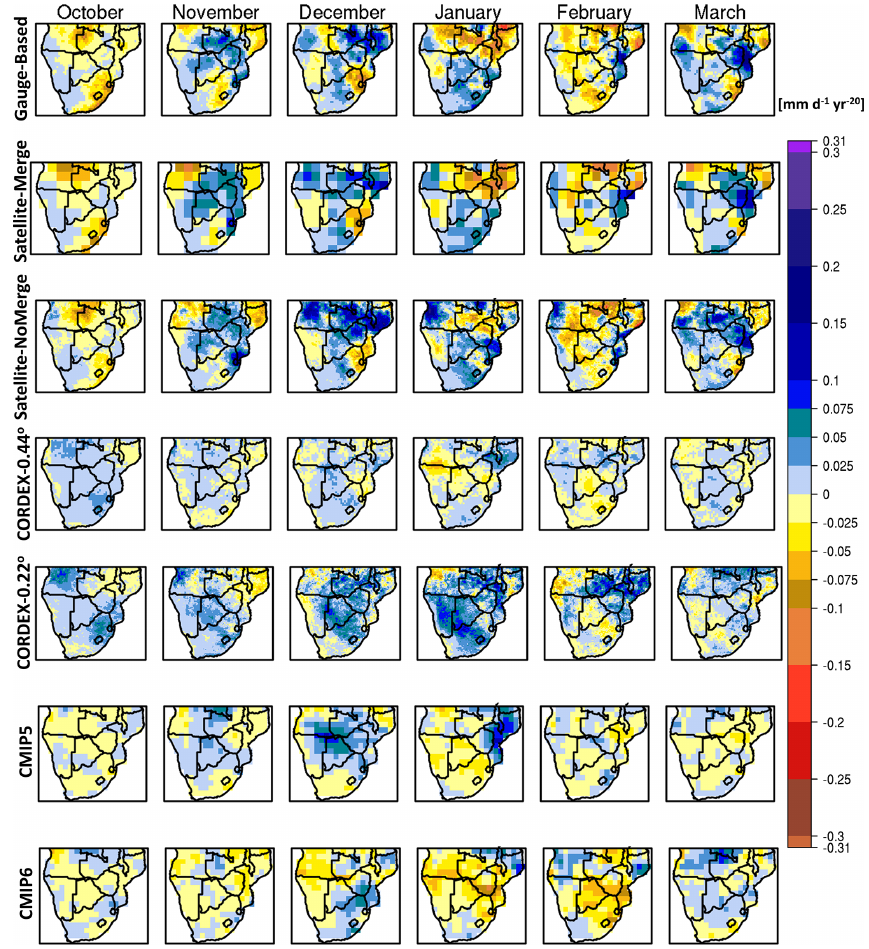
Figure 8. Trends for monthly precipitation for the period 1986–2005 [mmd − 1 per 20 years] calculated using Sen’s slope. Rows indicate the ensemble mean of trends produced by each ensemble member. From top to bottom – Gauge-Based: ensemble mean of datasets that were produced by employing spatial interpolation methods using rain gauges/station data. Satellite-Merge: ensemble mean of all satellite products that merge with rain gauges/station data. Satellite-NoMerge: ensemble mean of satellite products that do not merge with rain gauges/station data. CORDEX-0.44 ◦ : ensemble mean of regional climate model simulations performed in the context of the Coordinated Regional Climate Downscaling Experiment – Africa domain with a spatial resolution equal to 0.44 ◦ × 0.44 ◦ . CORDEX-0.22 ◦ : CORDEX-Africa simulations with a spatial resolution equal to 0.22 ◦ × 0.22 ◦ . CMIP5: ensemble mean of general circulation models participating in the Coupled Model Intercomparison Project Phase 5 (CMIP5) that were used as forcing in the CORDEX-0.44 ◦ simulations. CMIP6: ensemble mean of general circulation models participating in the Coupled Model Intercomparison Project Phase